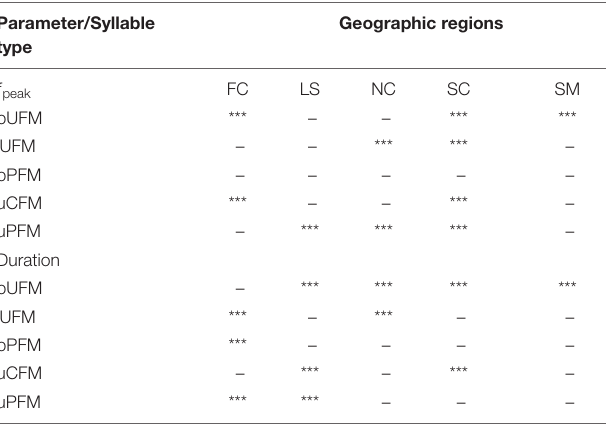
TABLE 1 | A comparison of the means of f peak and duration in syllable types across all pairs showing statistical significance ( P < 0.001) of differences, indicated by asterisks, between geographic regions.